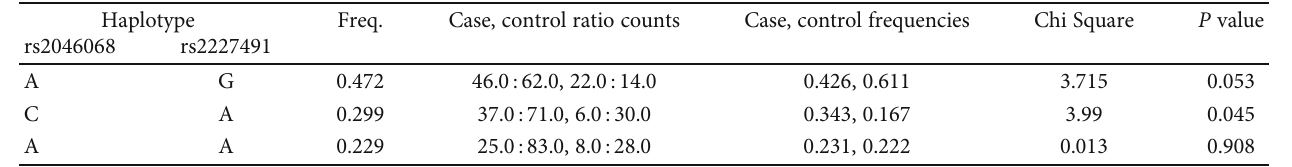
Table 10: Haplotypes of IL-22 gene when group 1-9 years of age was compared to 41 years and above. Haplotype Freq. Case, control ratio counts Case, control frequencies Chi Square P